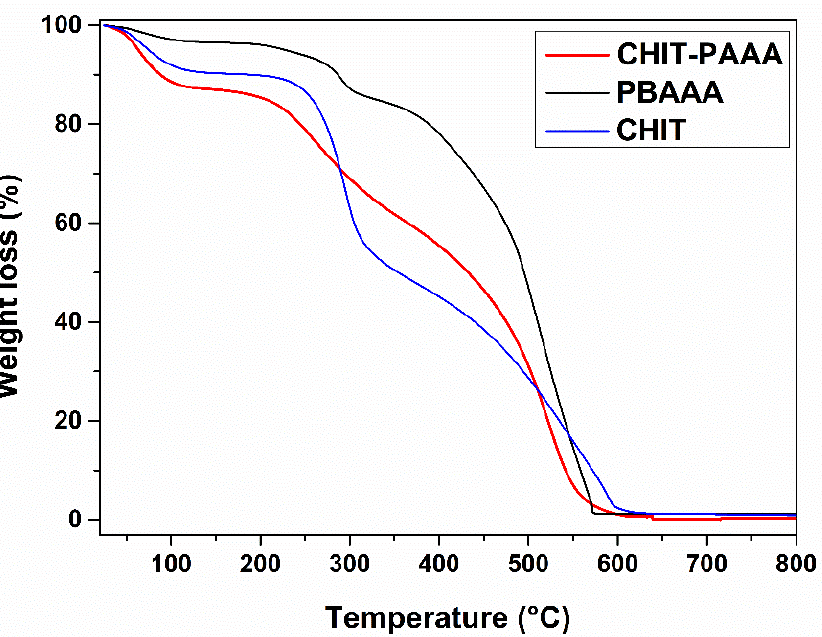
Figure 5. TGA curves of PBAAA (black), CHIT (blue) and CHIT-PAAA (red). PBAAA , CHIT , and CHIT-PAAA were also investigated through SEM (Figure 6). Major morphological differences can be seen: PBAAA resembles an arboreal self-assembling structure, while CHIT has a flat, uniform folded surface, and CHIT-PAAA forms aggregates with a cauliflower-like aspect. The rough, heterogeneous surface of CHIT-PAAA with many pores makes it suitable as an adsorbent for different applications.